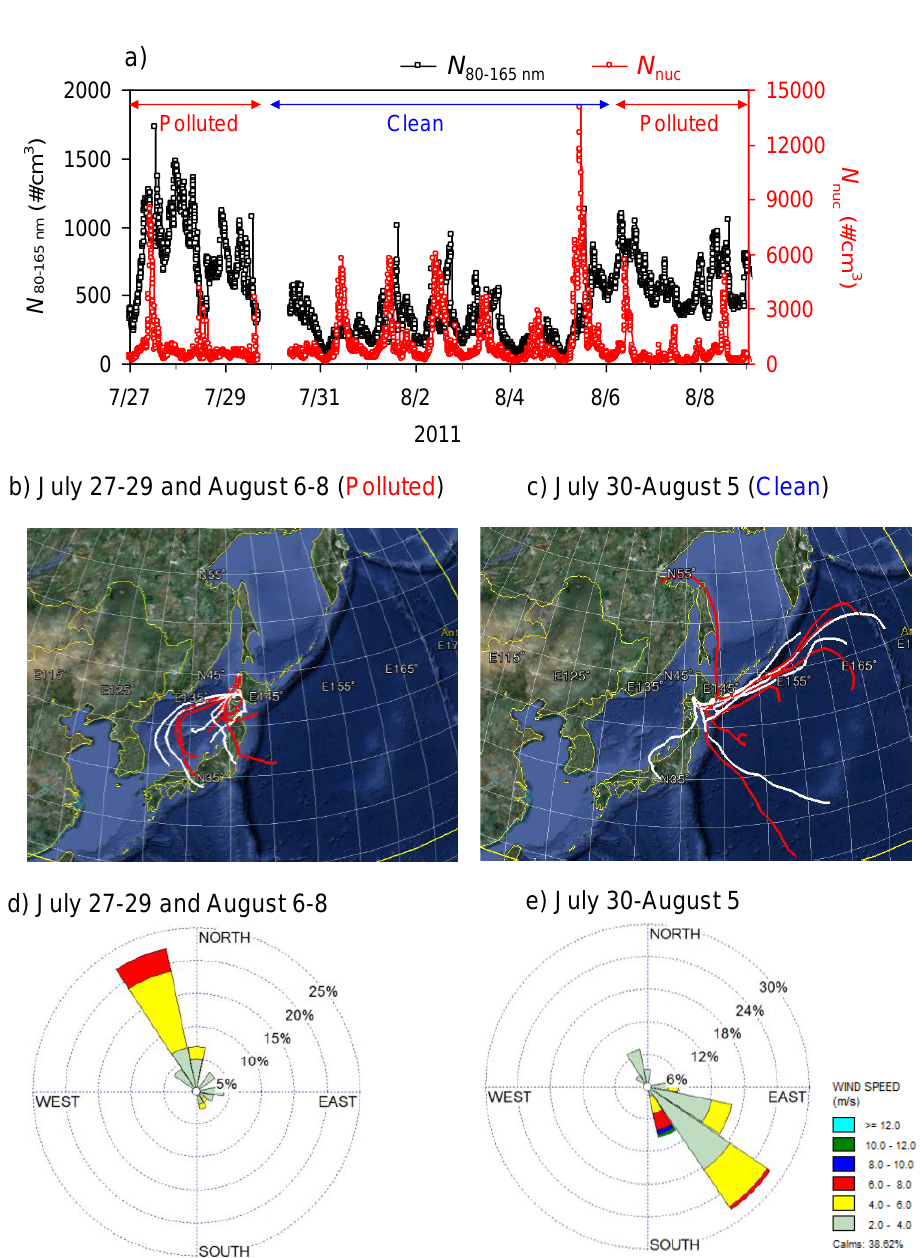
Figure 2. (a) Integrated number concentrations of particles from 80 to 165nm ( N 80 − 165nm ) and number concentrations of nucleation mode (7–30nm) particles ( N nuc ) during the entire measurement period, air mass backward trajectories arriving at the urban site, and observed frequencies of local wind direction with wind speed during the polluted periods (b) 27–29 July and (d) 6–8 August 2011, and the clean period (c, e) 30 July–5 August. White and red trajectories in (b) and (c) represent air mass trajectories arriving at heights of 200 and 500m, respectively, above ground